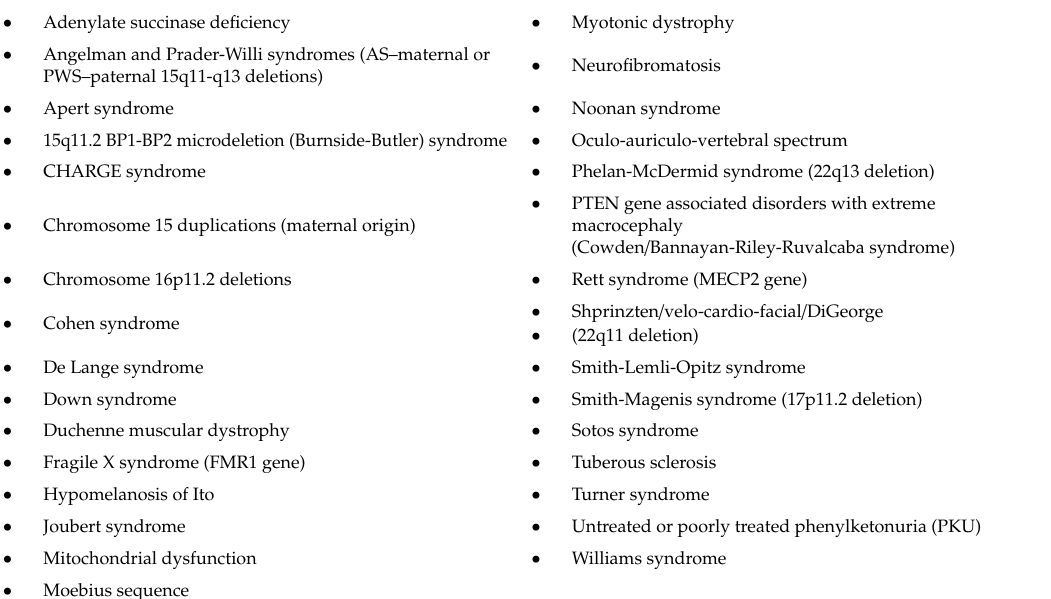
Box 1. A List of Genetic Syndromes and Chromosome Findings where Autism is a Recognized